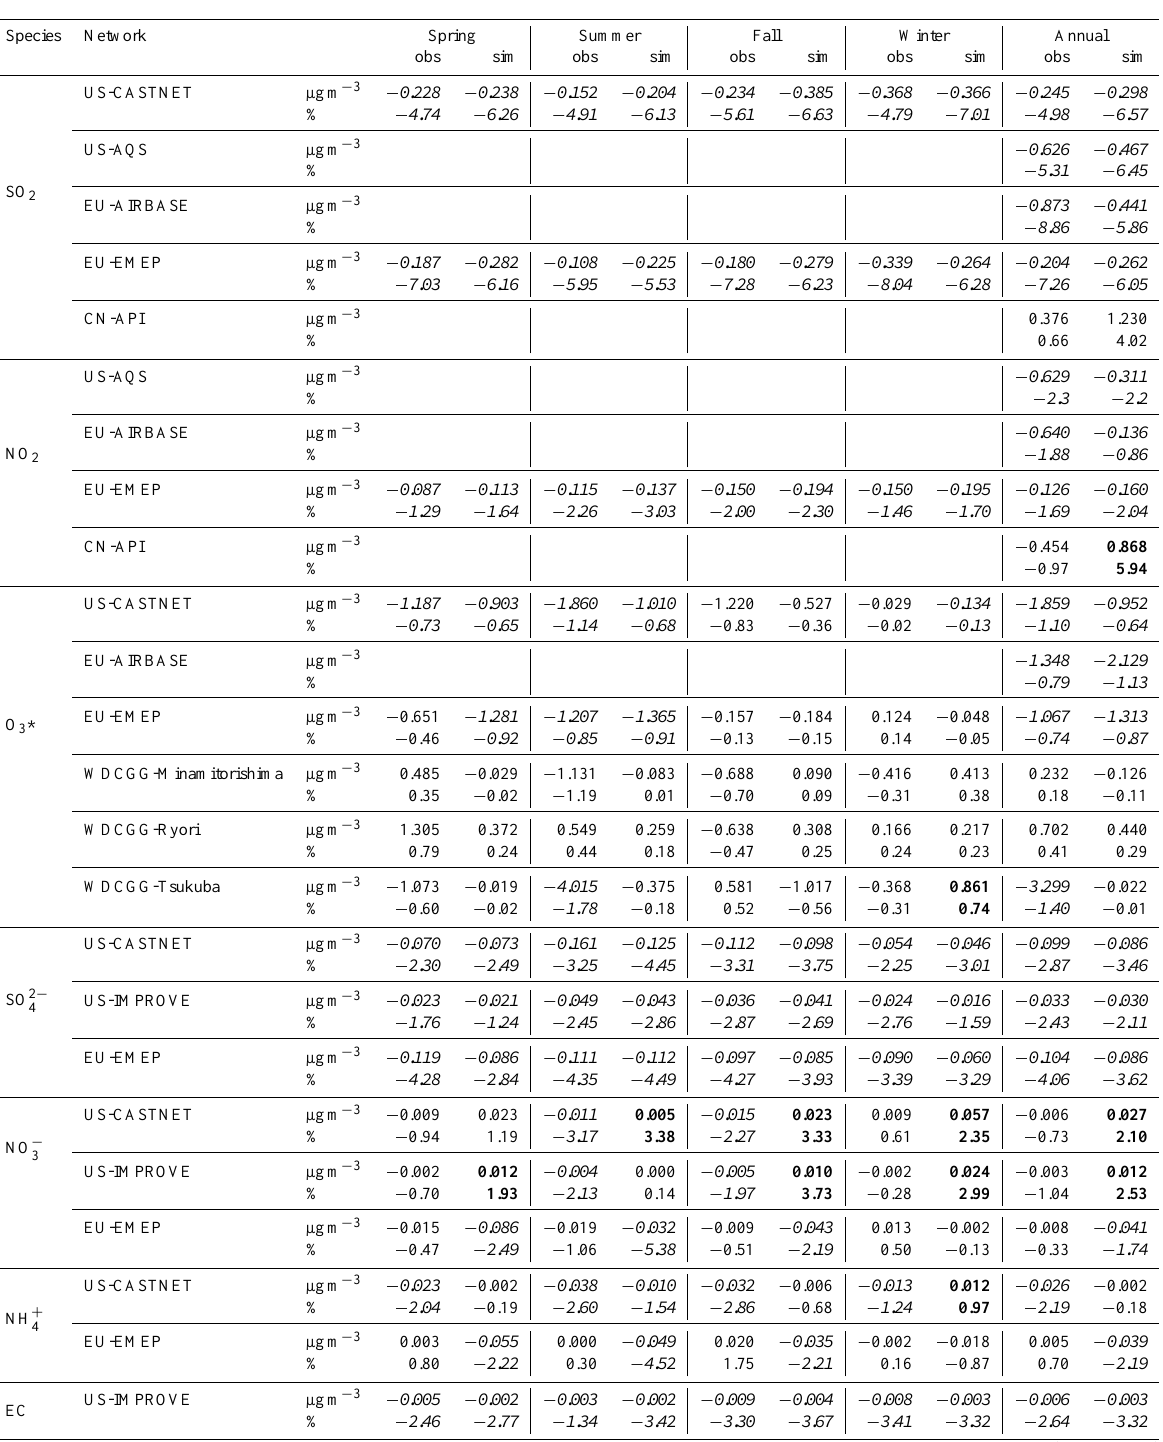
Table 4. Comparison of observed and simulated trends (µgm − 3 yr − 1 , computed on the basis of annual and seasonal means over the 1990– 2010 period with a linear least square fit method) and the annual change rate ( x %, i.e., concentration in the year Y ( C Y ) will be fit as C Y = C 1990 × (1 + x ) Y − 1990 )